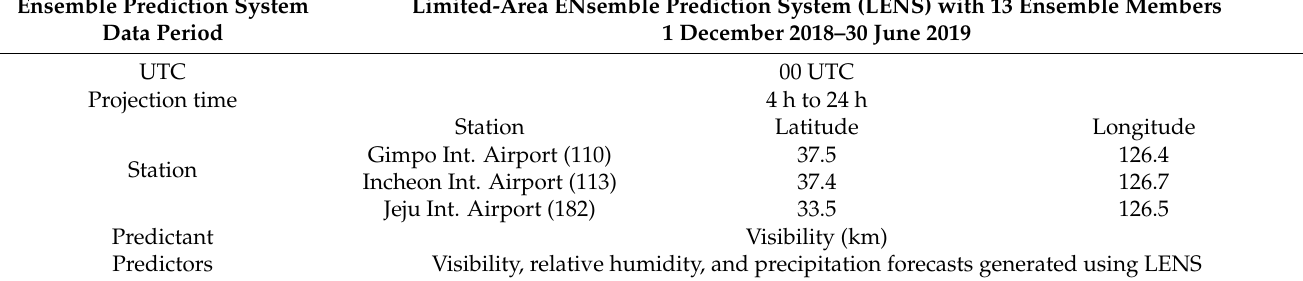
Table 1. Ensemble prediction system and stations used in the study.